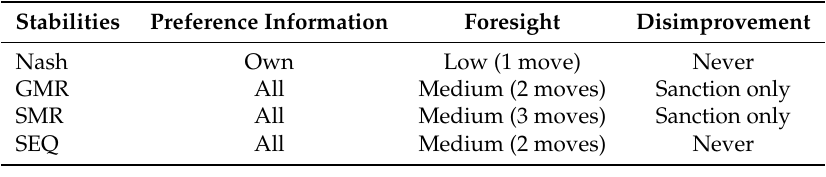
Table 1. The characteristics of stabilities [37,38]. GMR, General Metarationality; SMR, Symmetric Metarationality; SEQ, Sequential Stability.